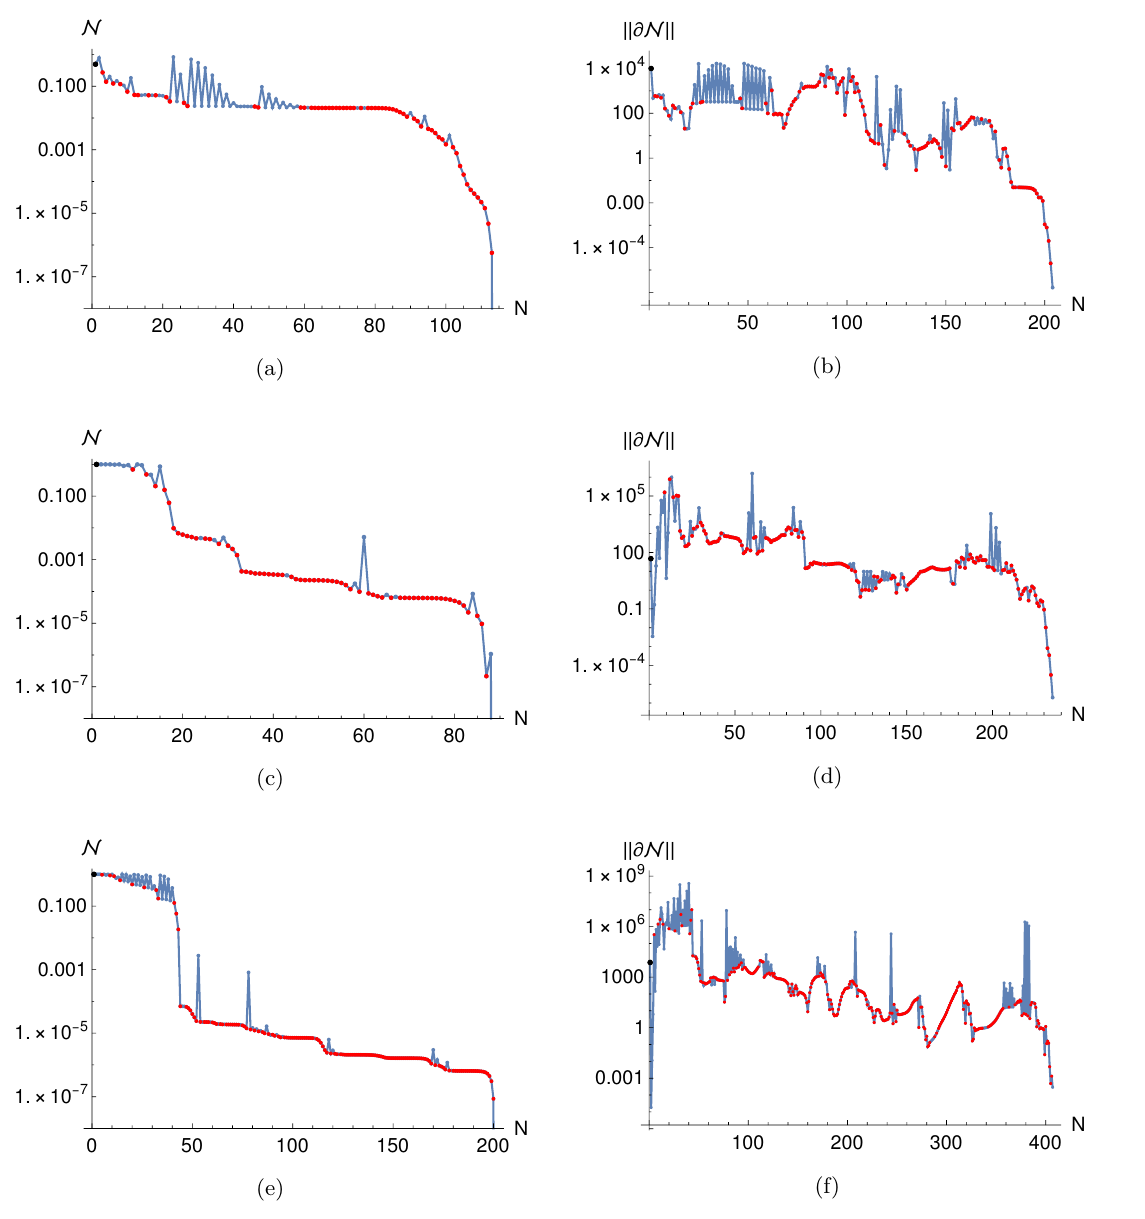
Figure 6 . (a), (c), (e): logarithmic plot of the navigator value N i at the i -th function call in a typical navigator minimization run for respectively a 4 , 7 and 13 dimensional parameter space. Only function calls before reaching the negative navigator region are shown. Red dots represent BFGS steps while blue dots indicate function calls within the line searches. (b), (d), (f): logarithmic plot of the norm of the gradient k ∂ Nk at the i -th function call for the same navigator searches.